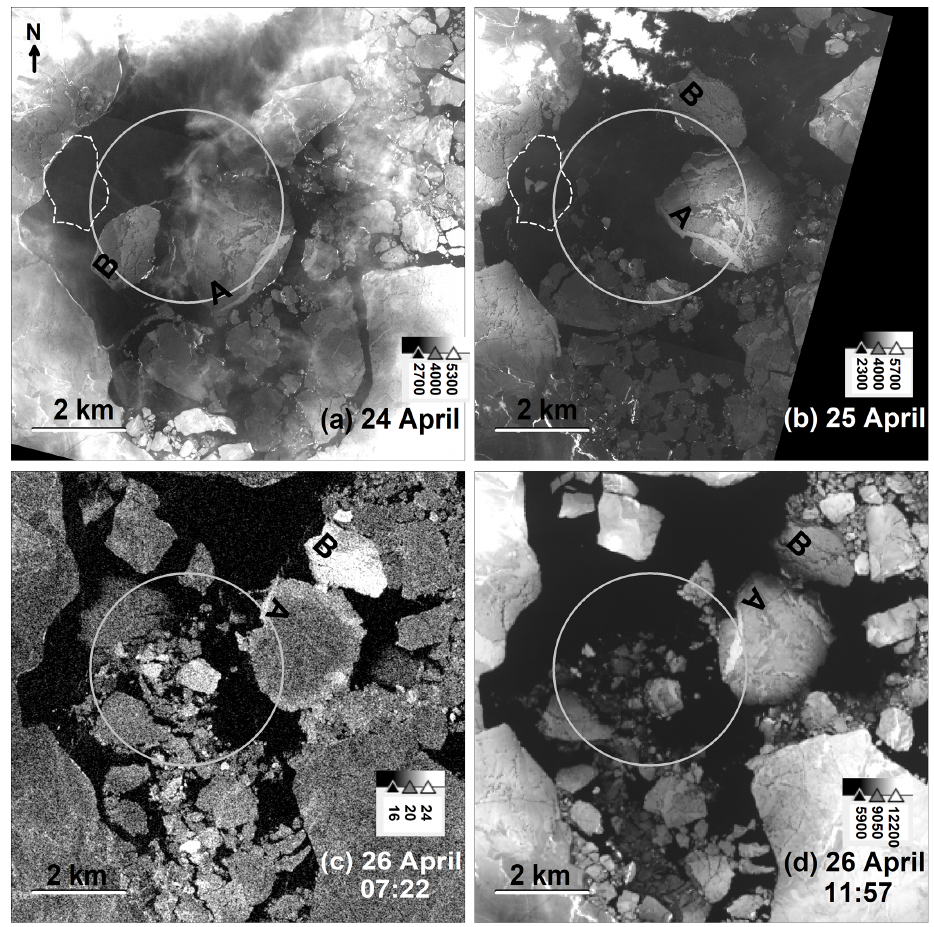
Figure 9. Same as Fig. 7, but (f) 24 April and (b) 25 April 2020, PlanetScope, red band, (c) 26 April 2020, Sentinel-1B SAR, VV polarisation (d) 26 April 2020, Landsat 8, red band. A and B – large ice floes mentioned in the text; dotted line in (a) and (b) – position of ice floe B on 23 April 2020. White linear features – cracks; black areas – open water. All time for satellite images is local time (GMT + 8). Colour stretching is different for each image to enhance the contrast. Grey palette on (a) , (b) and (d) – reflectance units (digital numbers) specific for each satellite; (c) decibel values. Projection UTM